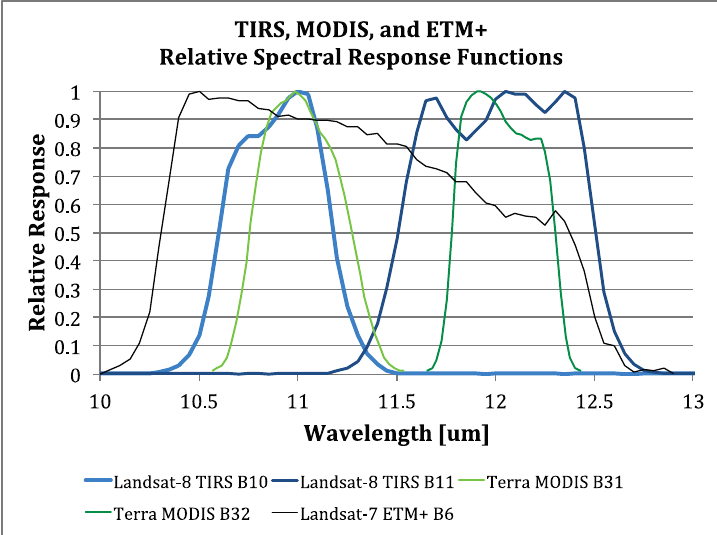
Figure 3. The relative spectral responses (RSR) of the TIRS bands (B10 and 11). Also shown for comparison are the RSRs of ETM+ band (B6) and the equivalent MODIS bands (B31 and 32). The TIRS and ETM+ RSRs are band-average but the MODIS RSRs are each for a specific detector (detector 5 in both